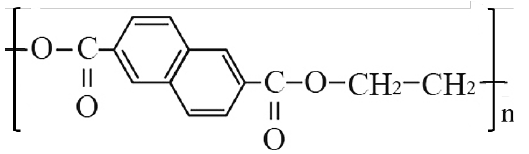
Figure 1. Chemical formula of the polyethylene naphthalate.